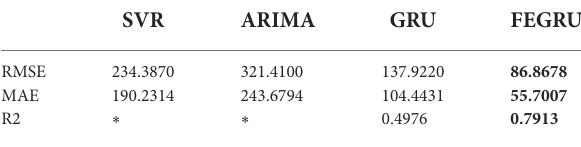
TABLE 1 guangfu-60min.